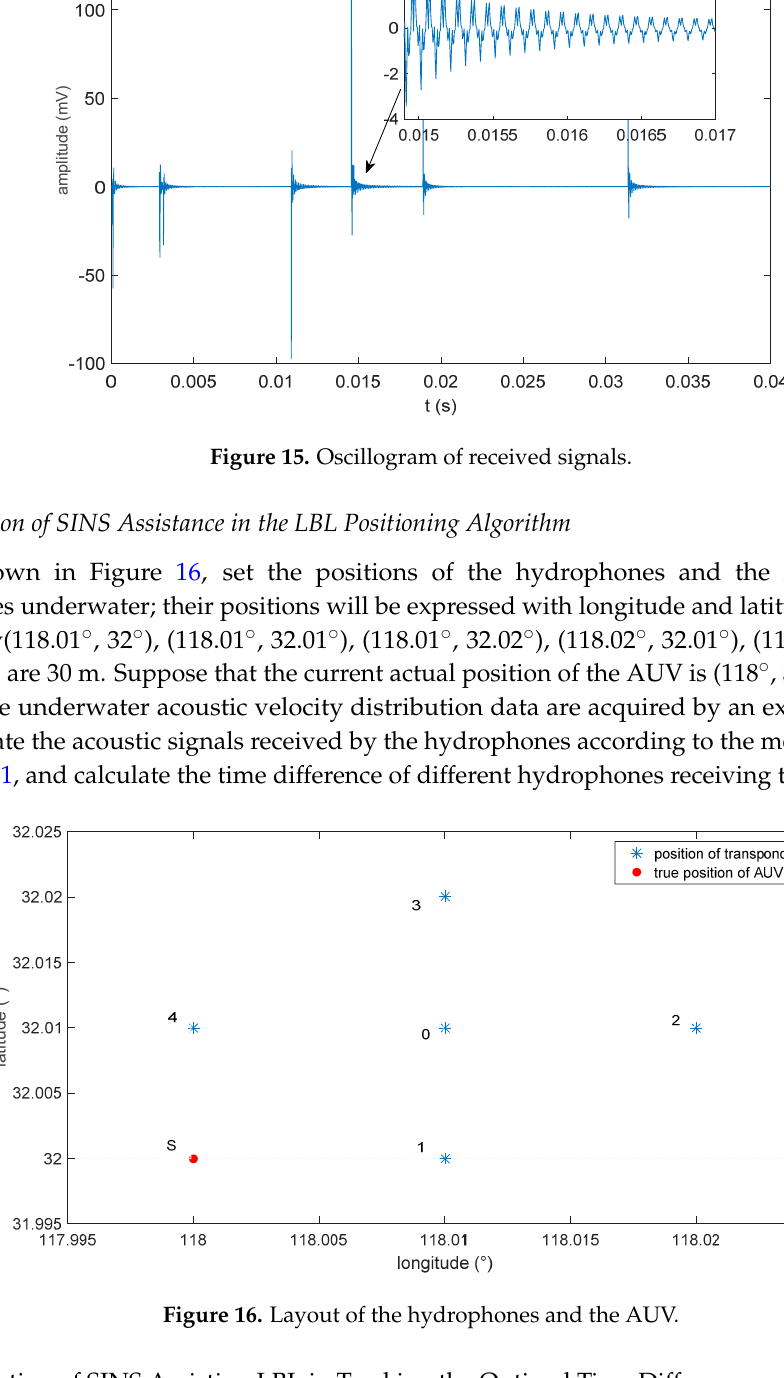
Figure 14. Unit impulse response h(t)